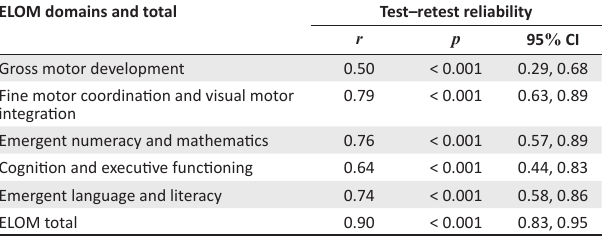
TABLE 1: Test–retest reliability coefficients for the Early Learning Outcomes